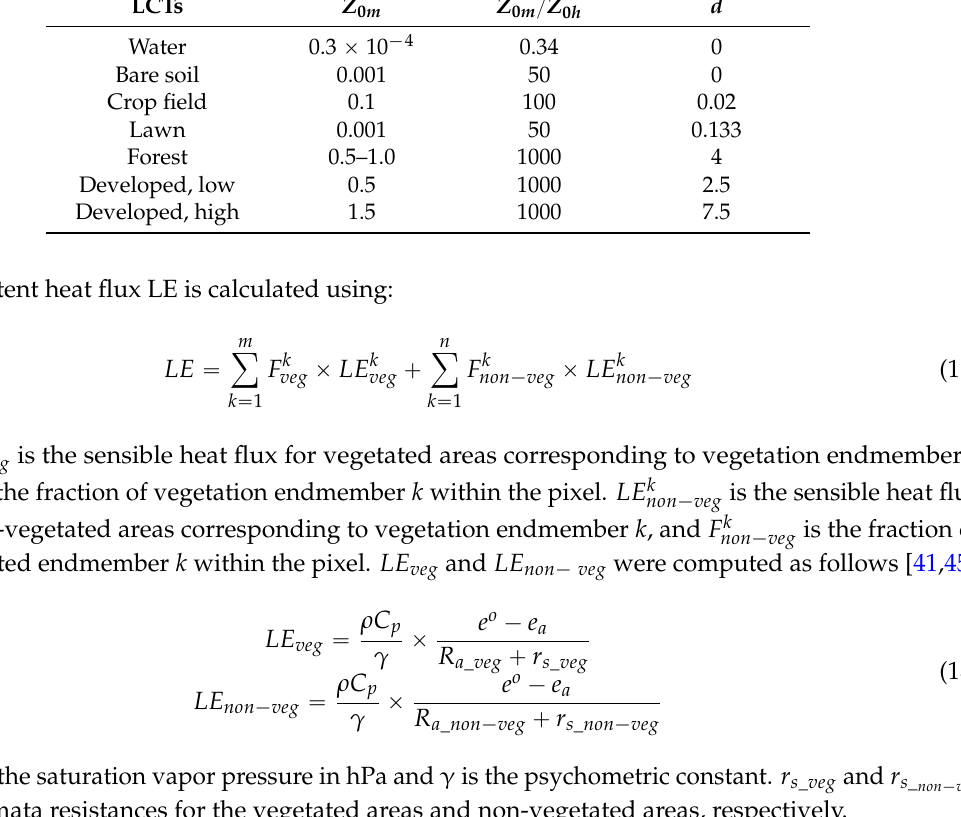
Table 2. Parameters used for surface coverage types. LCT, land cover type. LCTs Z 0 m Z 0 m { Z 0 h Water 0.3 ˆ 10 ´ 4 Bare soil